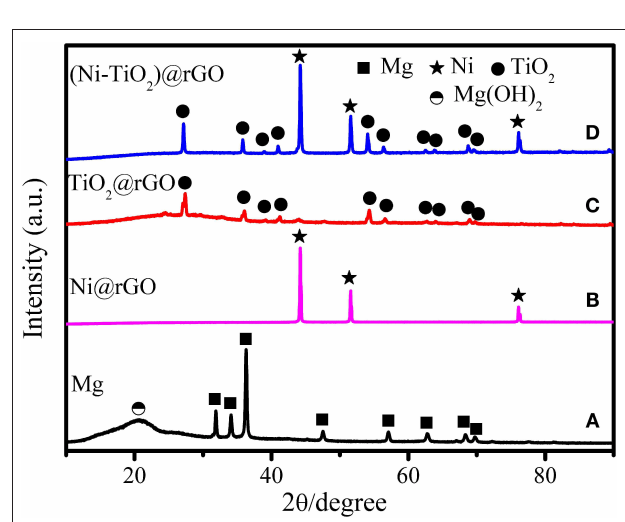
FIGURE 2 | XRD patterns of as-prepared (A) Mg, (B) Ni@rGO, (C) TiO 2 @rGO, and (D) (Ni-TiO 2 )@rGO